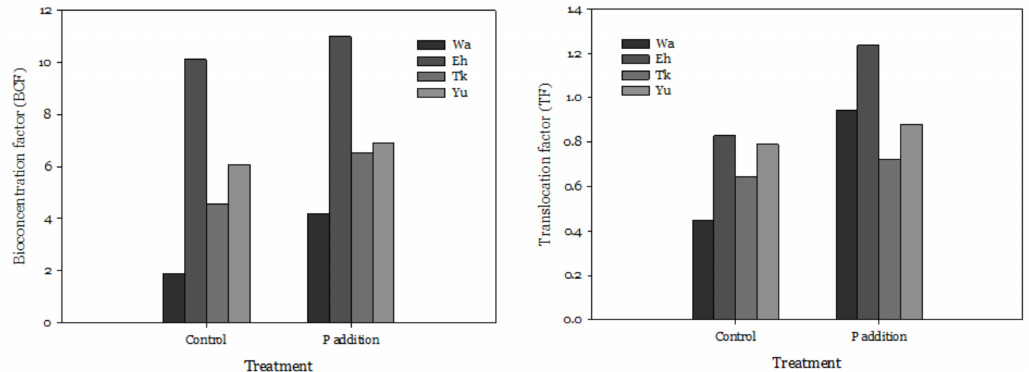
Figure 3. E ff ect of adding P on the bioconcentration factor (BCF) and translocation factor (TF) of water spinach. The meanings of the abbreviations are the same as in Table 2.